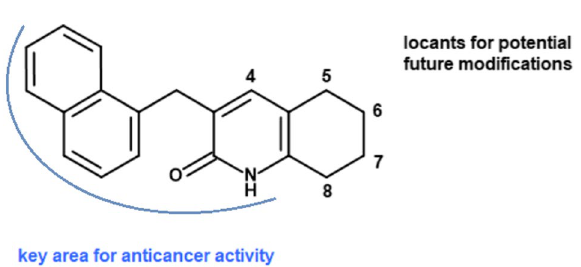
Figure 7. Conclusion of structure–activity relationship studies of the presented tetrahydroquinolinone